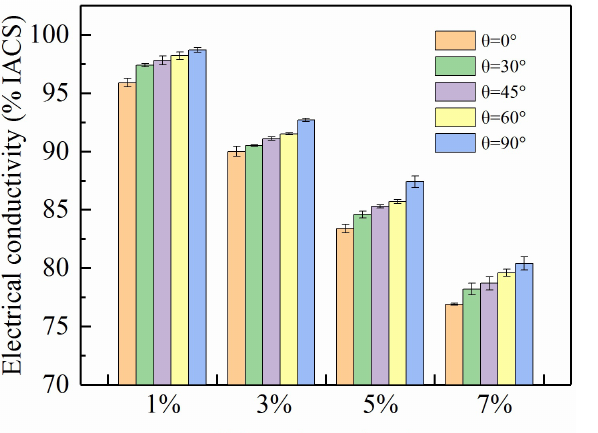
with some defects in the material. (Such as impurity atoms, second phase, grain boundaries, etc.).